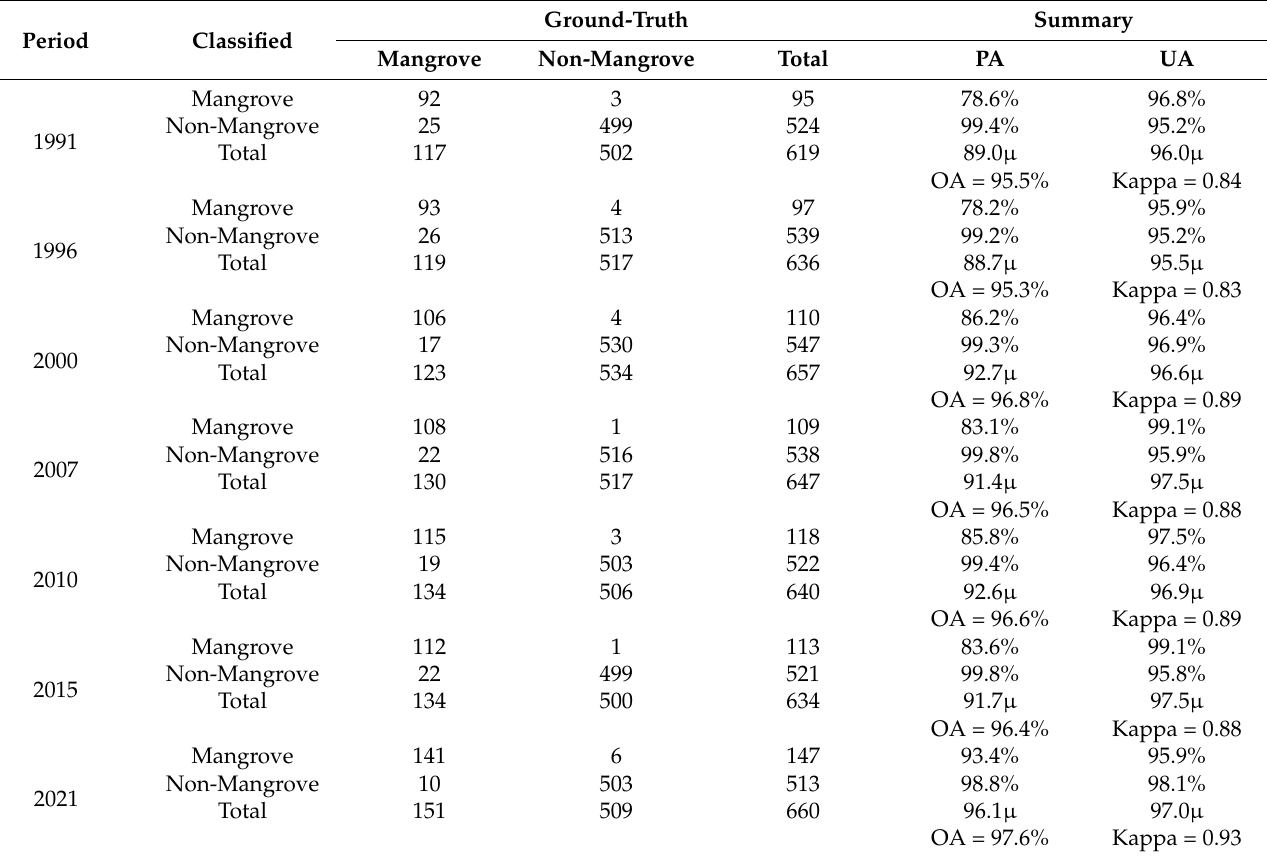
Table 3. Accuracy assessment of Res-UNet classification results of mangrove forests in the Hainan Island during 1991–2021, where µ depicts the averaged values.